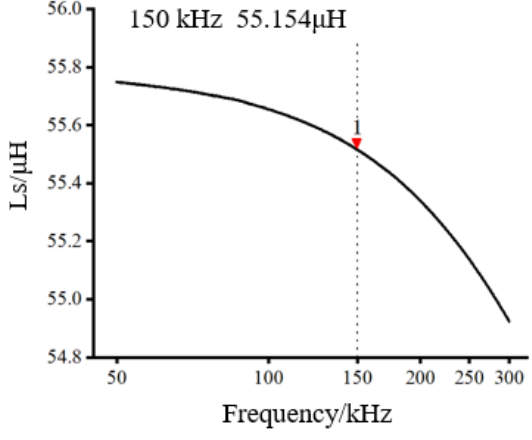
Figure 5. Excitation coil inductance. According to the measured inductance value, based on the relevant theories of parallel resonant, we calculated that the 20.162 nF capacitor and the excitation coil were applied to form the LC parallel resonant circuit. The frequency of the excitation coil LC parallel resonance was measured by the Impedance Analyzer. On the basis of characteristics that the impedance value is maximum with the LC parallel circuit resonates, the frequency of the excitation coil LC parallel resonance was measured to be 150.26 kHz, as shown in Figure 6.